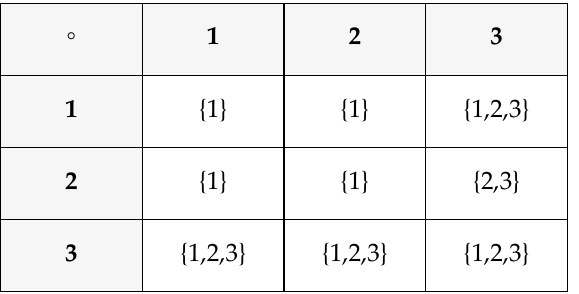
Table 13. A non-commutative hypergroup which is also left and right almost-hypergroup.